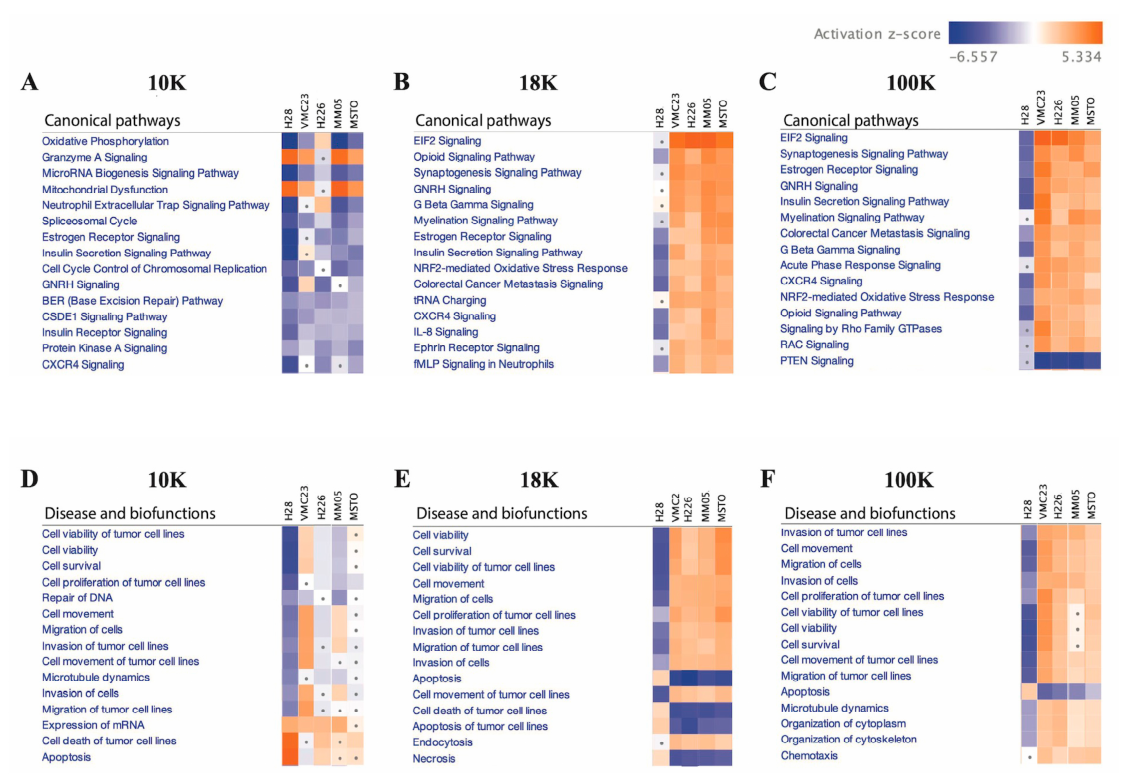
Figure 9. IPA analysis showing the activation or inhibition levels of cancer-related molecular pathways in ( A ) 10 K, ( B ) 18 K, and ( C ) 100 K pellets, and the biological functions in ( D ) 10 K, ( E ) 18 K, and ( F ) 100 K pellets compared to the corresponding MeT-5A control. Data derived from four biological replicates.